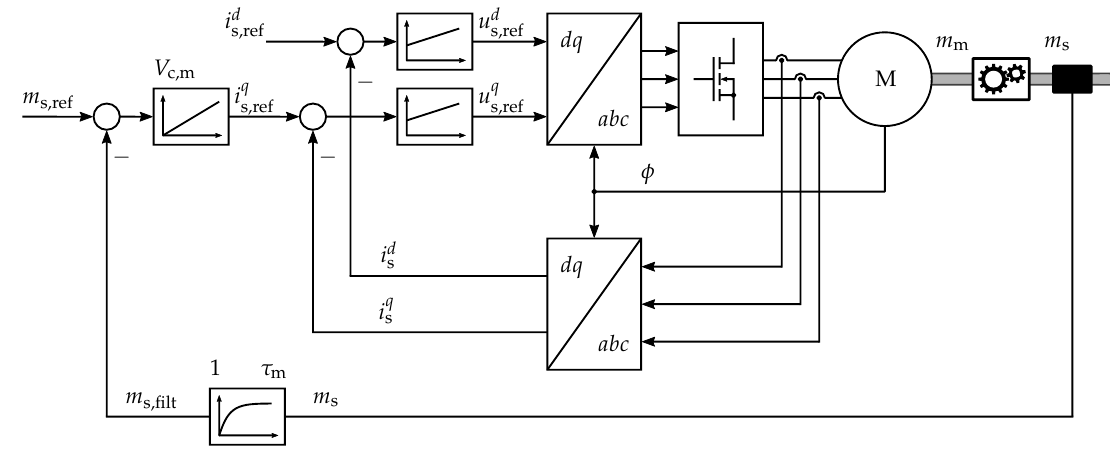
Figure 6. Signal flow diagram of the current control loops with the outer torque control